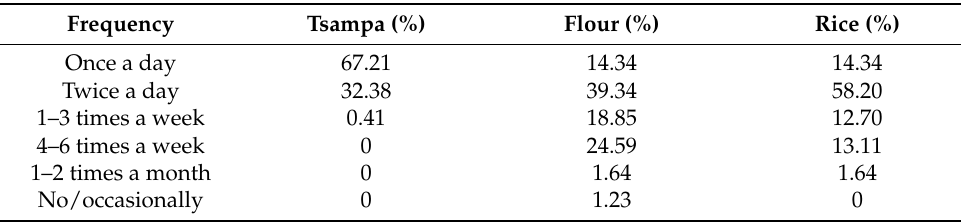
Table A1. Frequency of staple grain consumption in the